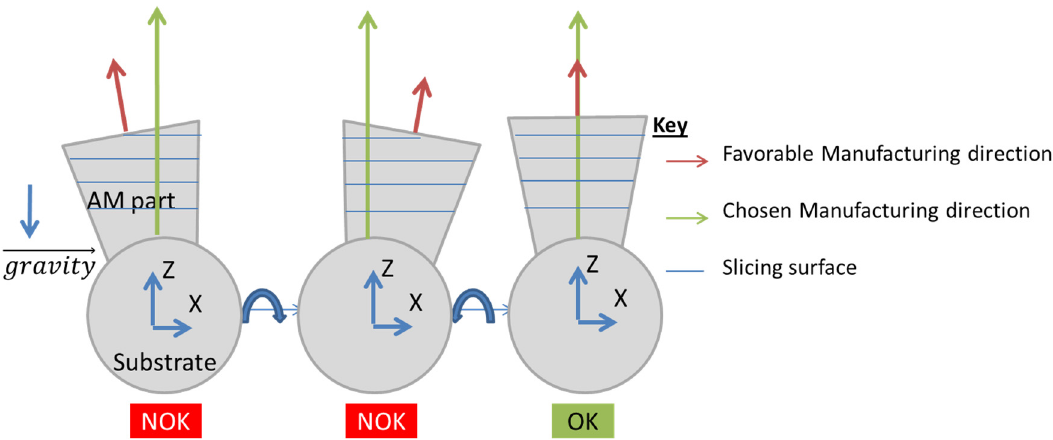
Figure 3. Example of manufacturing direction selection.